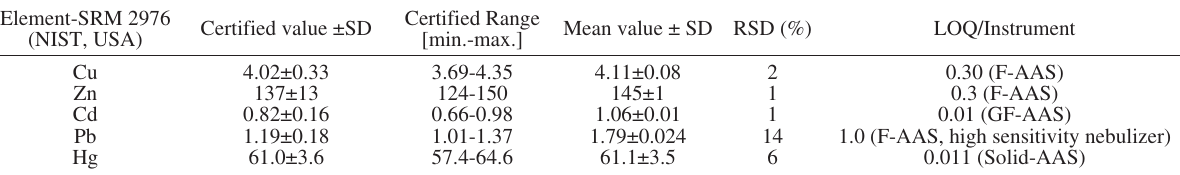
Table 1. – QA/QC data (mg kg –1 DW) for the certified reference material SRM 2976 (NIST, USA), accuracy, precision, LOQ and analytical method. SD, standard deviation; RSD, residual standard deviation; LOQ, limit of quantification; F-AAS, flame-atomic absorption spectrom- etry; GF-AAS, graphite furnace-atomic absorption spectrometry; Solid-AAS, direct solid-sample combustion atomic absorption spectrometry. All concentrations are reported on a dry weight (DW) basis. Element-SRM 2976 (NIST,